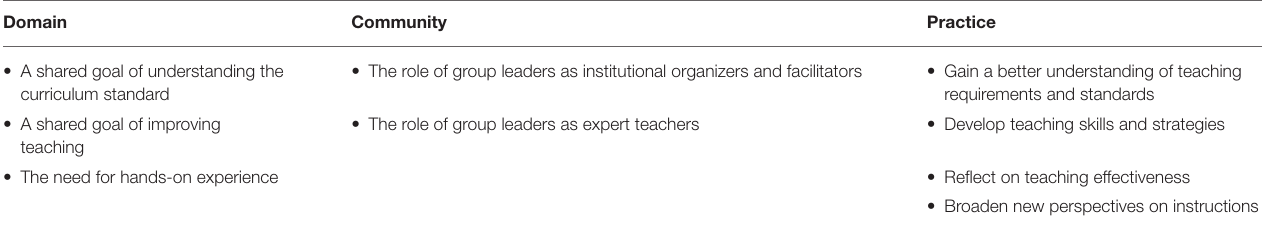
TABLE 2 | Coding themes and categories.